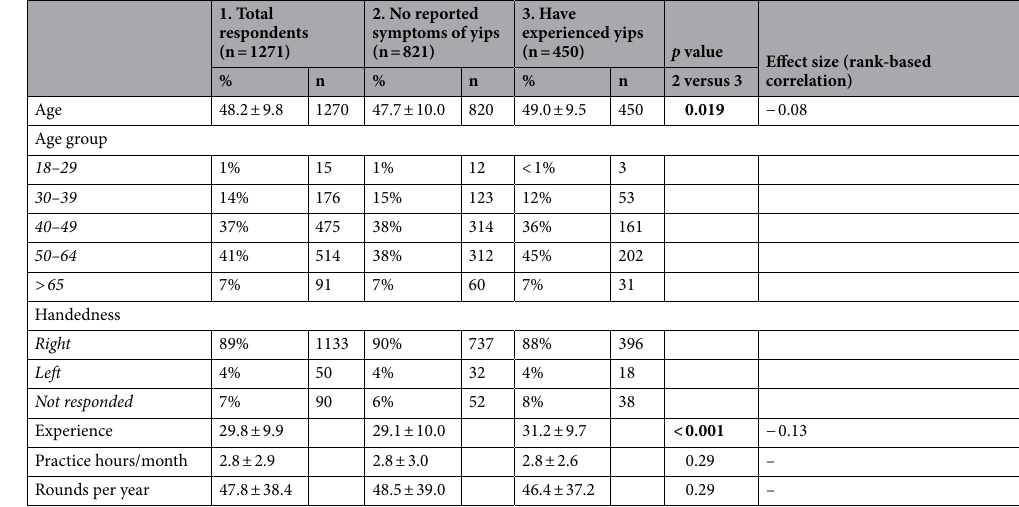
Table 1. Demographic characteristics of professional golfers. Reported p values are derived from Mann– Whitney non-parametric test. Significant p values are shown in bold.